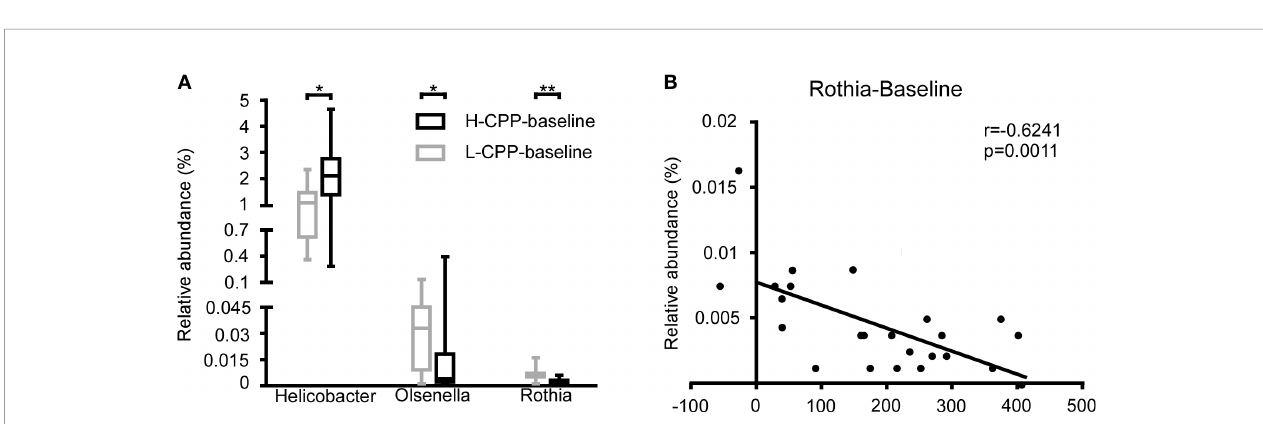
FIGURE 7 | Comparison of the gut microbiota composition between L-CPP and H-CPP groups at baseline and the correlation between the relative abundance of Rothia at baseline and CPP score. (A) The signi fi cant differences among Helicobacter , Olsenella , and Rothia were noted. A Mann-Whitney test was used to analyze the data. A Wilcoxon signed rank test was used to analyzed the data. A student ’ s t test was used for data with Gaussian distribution. The central line shown in each box plot indicates the median of data. Whiskers extend to cover the whole range of values. Statistical signi fi cance was accepted at p<0.05. (B) The relative abundance of Rothia was negatively correlated with the CPP score. Spearman correlation was performed for Rothia . The r value and p value were used to evaluate statistical signi fi cance. *p<0.05; **p<0.01; ***p<0.001;